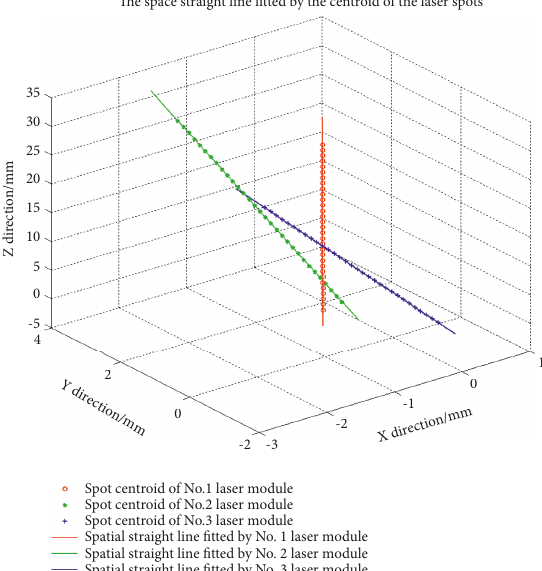
Figure 14: Three fitted laser beams.